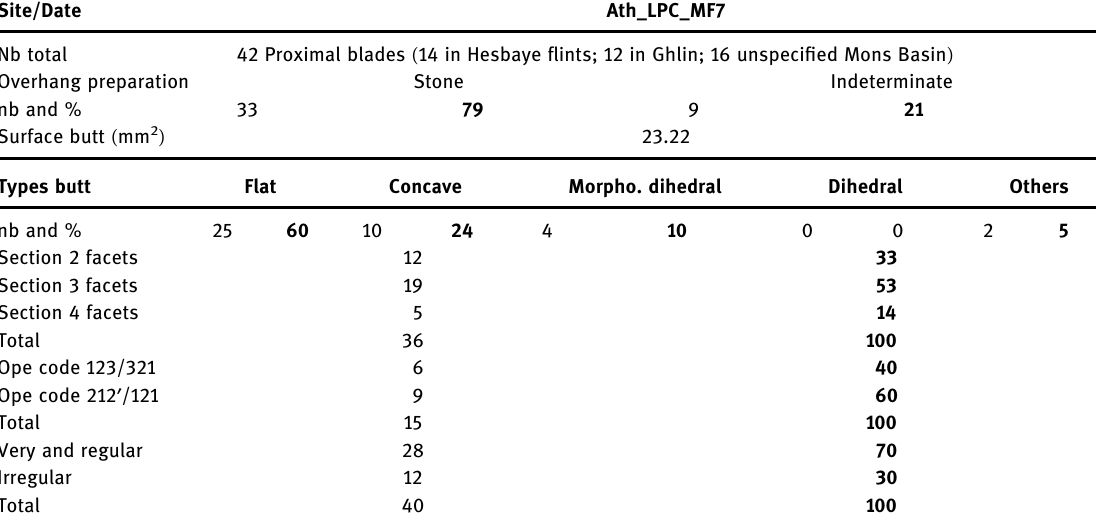
Table 6: Summary indicating the descriptive technical criteria of the blades attributed to MF7, at Ath “ les Haleurs, ” LPC